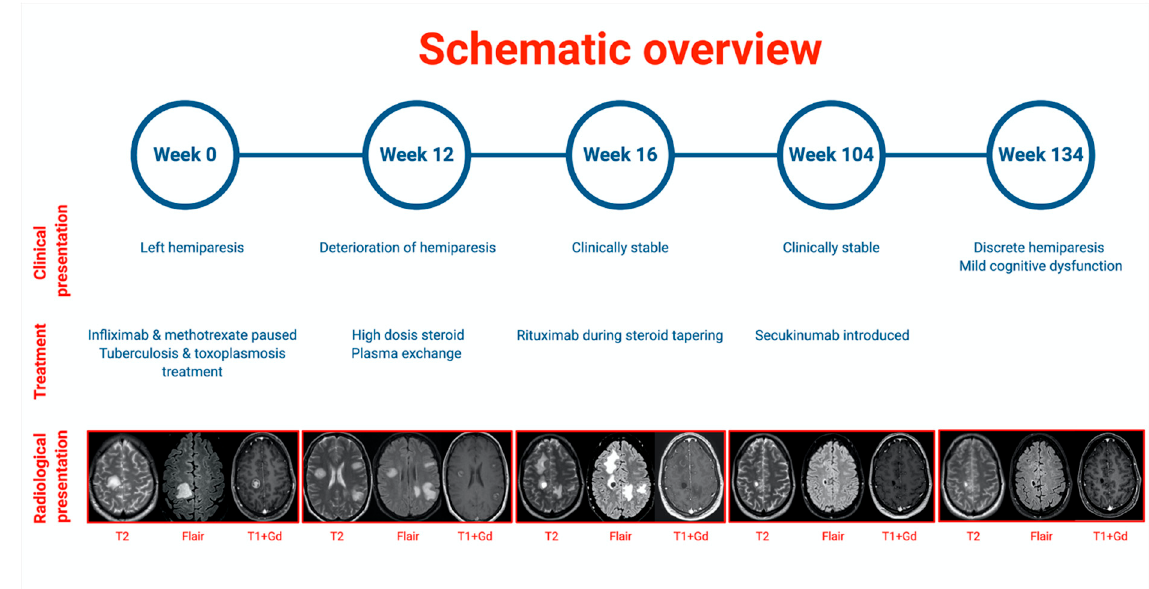
Figure 1. Schematic overview of the case, showing the relationship between clinical presentation, treatment, and radiological presentation shown by MRI scans (T2, Flair, and T1+gadolinium enhancement). Created with BioRender.com.